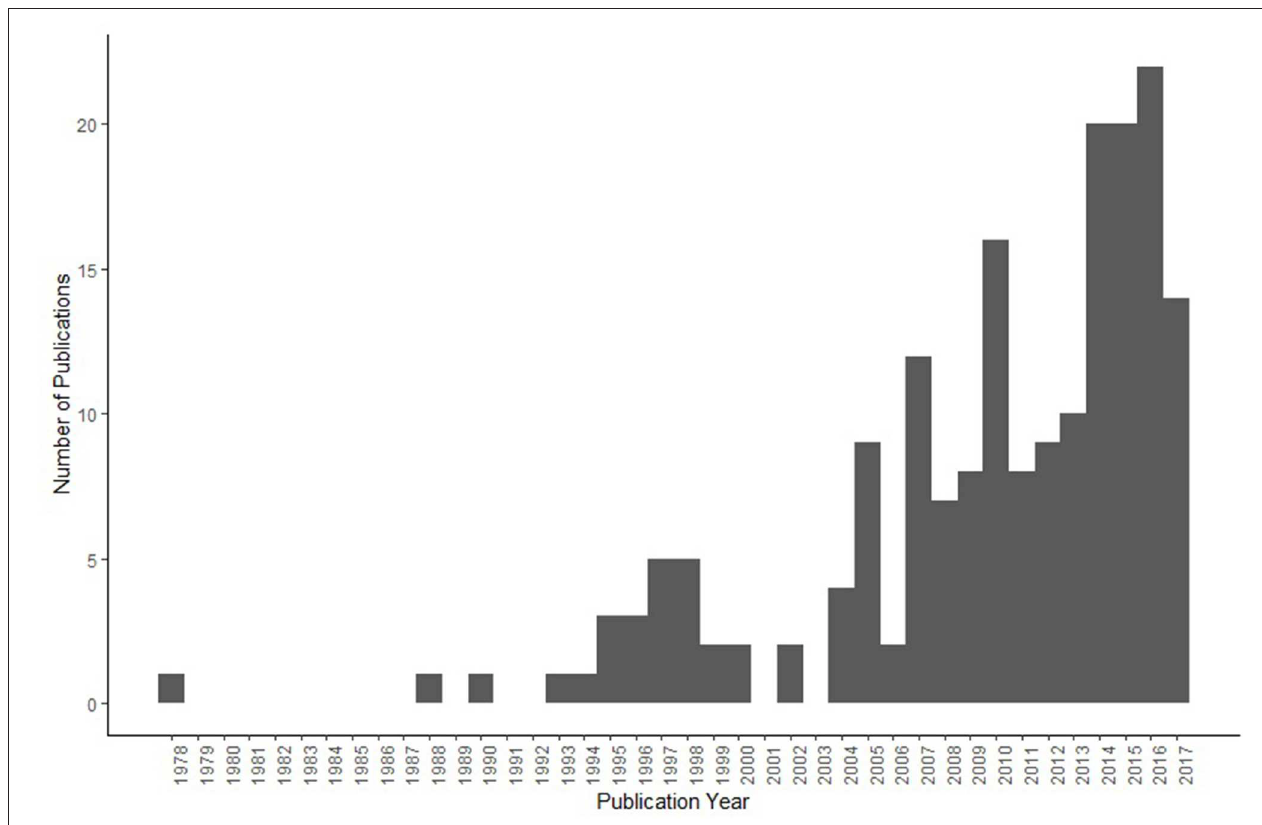
FIGURE 2 | Publications by year ( n = 188) in Web of Science Search. Topic Boolean search string: “Animal Welfare” and